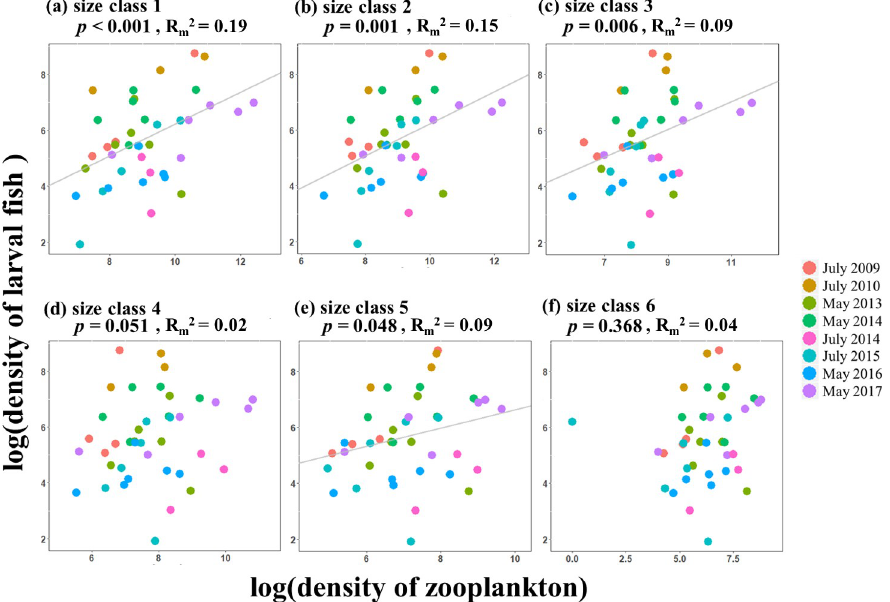
Fig 3. Relationships between densities of six size classes of small-size zooplankton and larval fish density at log- log scale. Colors indicate different cruises; grey lines indicate significant regression from linear mixed-effects models. P -values and marginal R-squared values are reported.